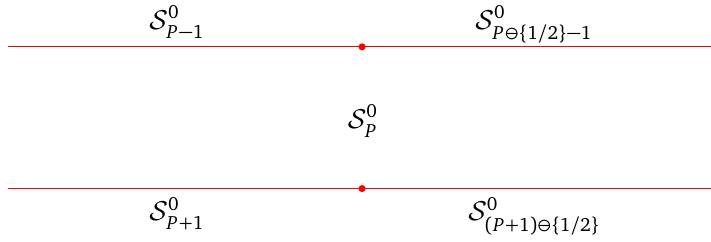
Figure 13: Two choices for a fundamental domain of R under the action of ˇ g , from which ˇ R = R / ˇ g is built. The fundamental domain is the hatched portion. How sheets are glued together along branch cuts (red lines, with dots for the branch points) is not represented for clarity. The picture on the left represents all sheets (cid:67) , P (cid:64) (cid:90) + 1 / 2 P above one another, with the fundamental domain made of the infinite strips S 0 cor- P responding to points [ v , P ] with − π < Im v ≤ π . The picture on the right represents half-sheets (cid:67) l grouped according to the value of min P (if P (cid:54) = (cid:59) ; the half-sheet P (cid:67) l is cut into half-infinite strips S l, m ) and half-sheets (cid:67) r grouped by the value of (cid:59) (cid:59) P | P | − | P | + − .